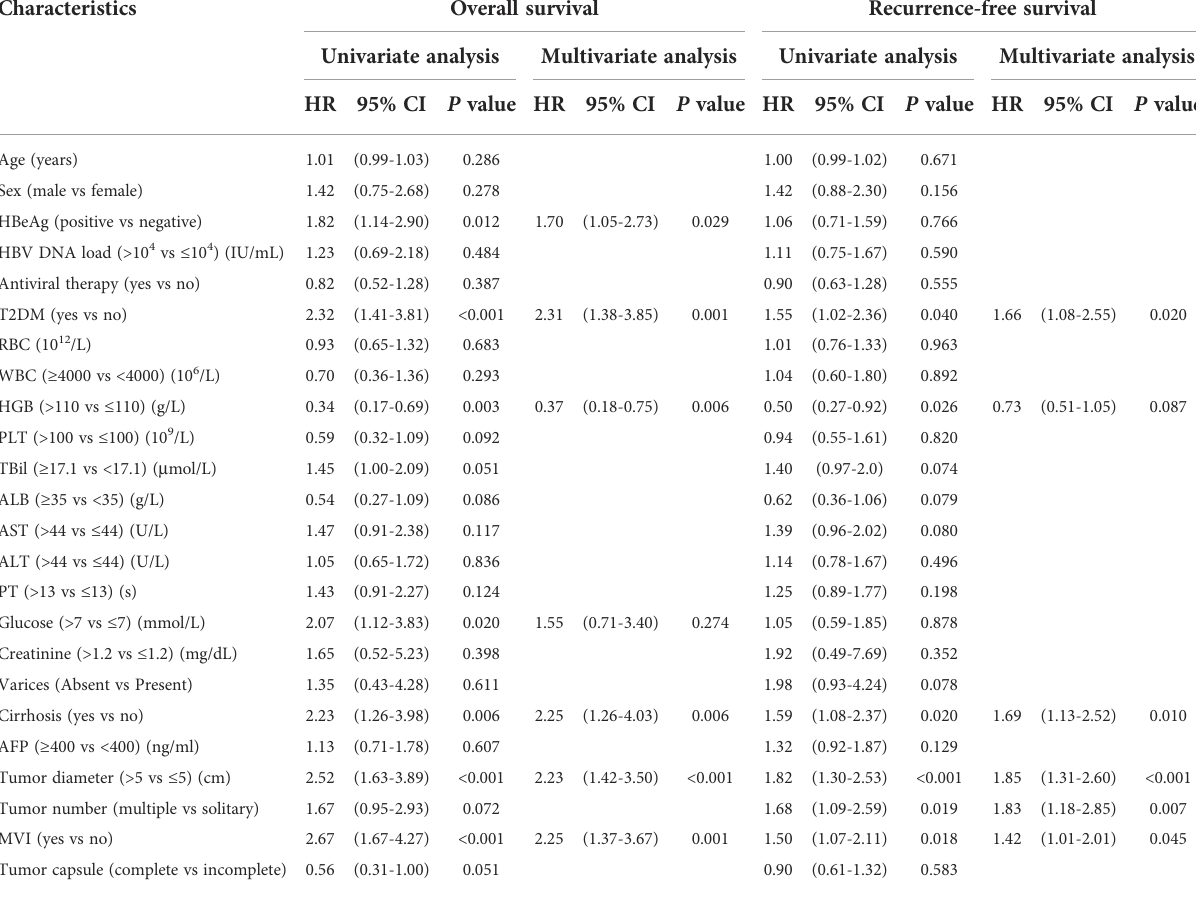
TABLE 2 Univariate analysis and multivariate Cox analysis of overall survival and recurrence free survival for all HCC patients (n=402). Characteristics